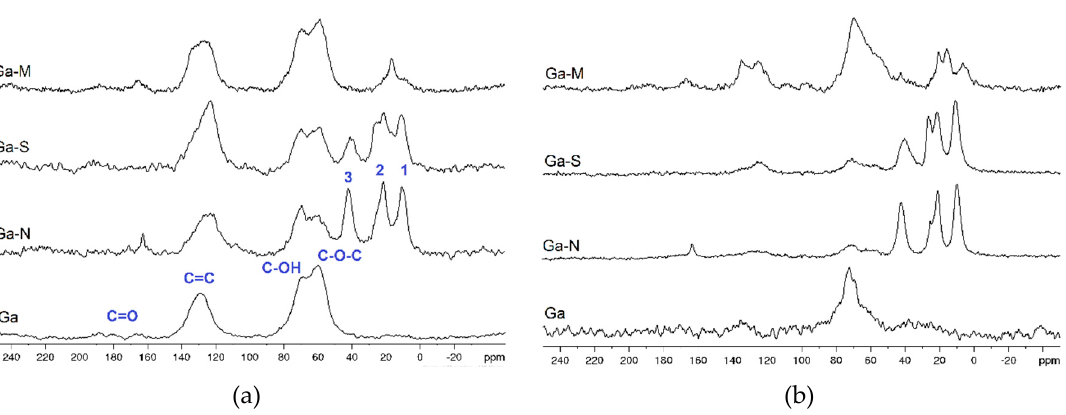
Figure 1. 13 C solid state NMR spectra of the samples Ga, Ga-N, Ga-S, and Ga-M. ( a ) Decoupled MAS and ( b ) CPMAS.